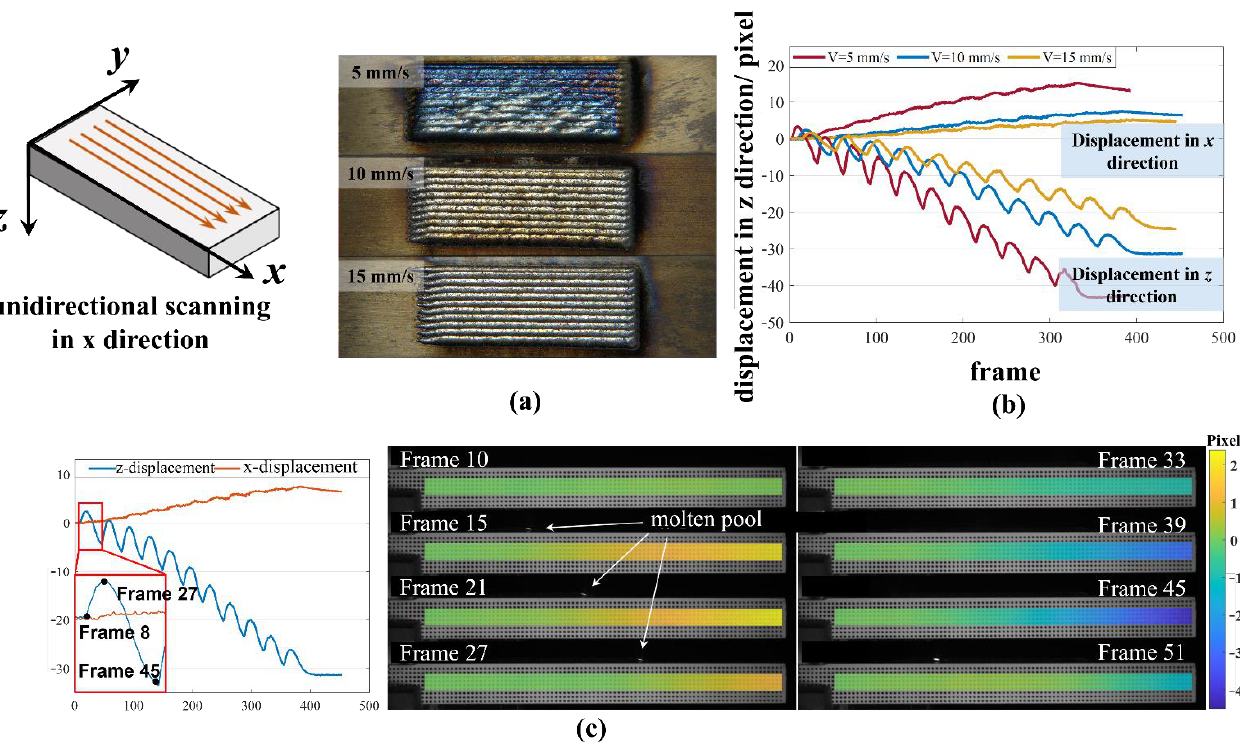
Figure 15. ( a ) Cladding results at different scanning speeds, ( b ) displacement evolution at different scanning speeds and ( c ) z -direction displacement field in a single cycle at 10 mm/s.